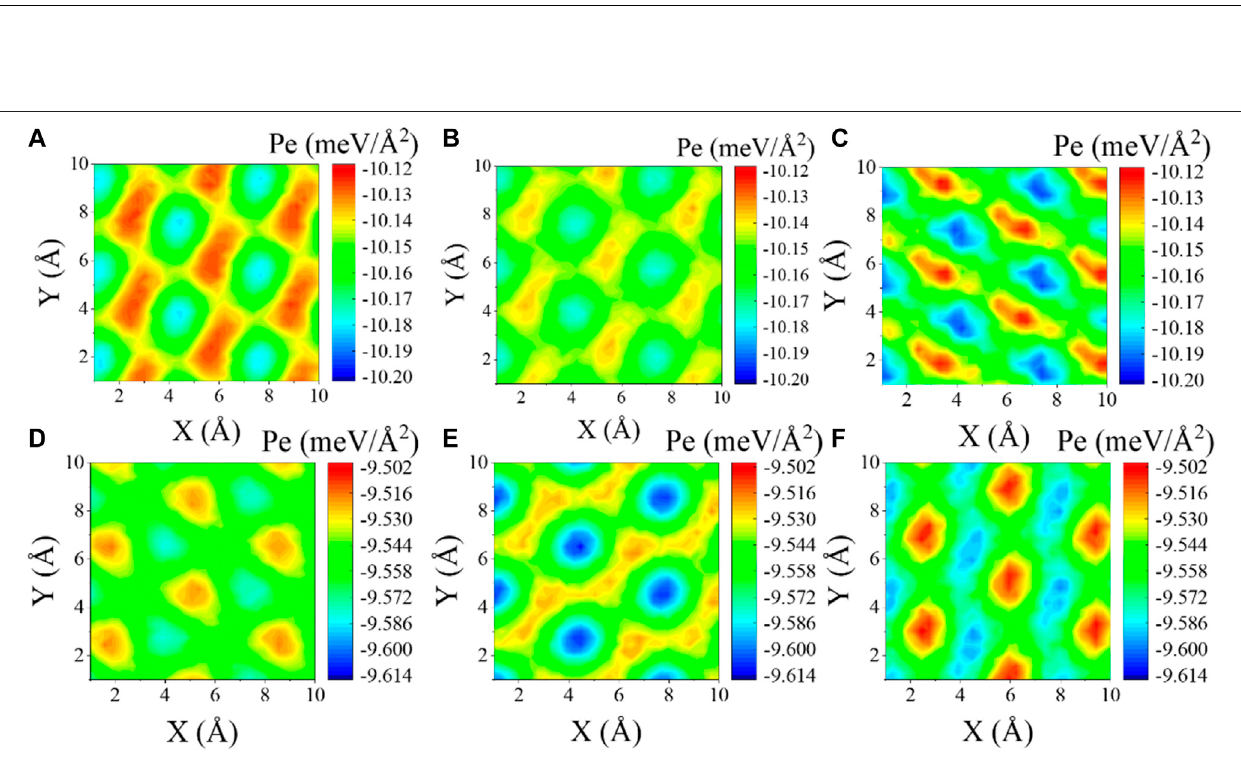
Frontiers in Mechanical Engineering |